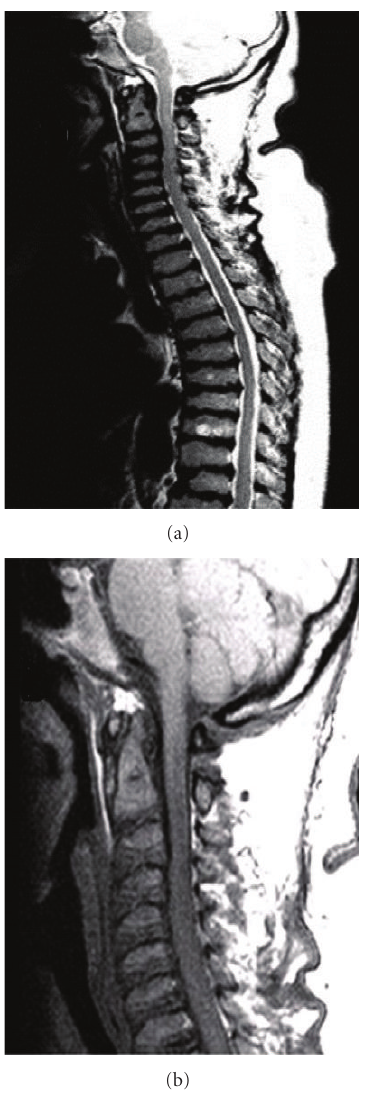
Figure 5: (a) MRI sagittal TSE T2 view of the cervico-thoracic spine. (b) MRI sagittal T1 view of the cervical spine showing hypoplasia of the odontoid process with a mild cord compression at the level of C2-C3.